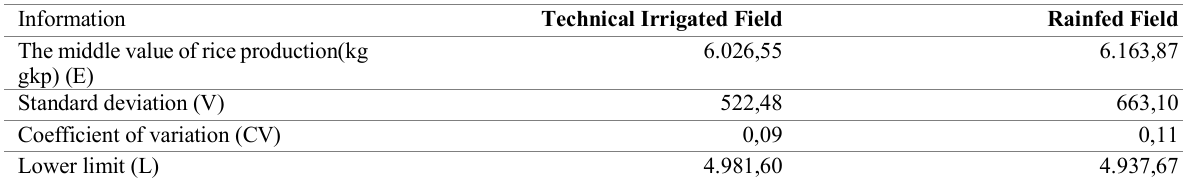
Table 1: Production Risk of Rice Farming on Technical Irrigated Rice Field and Rainfed Rice Field in South Lampung Regency.